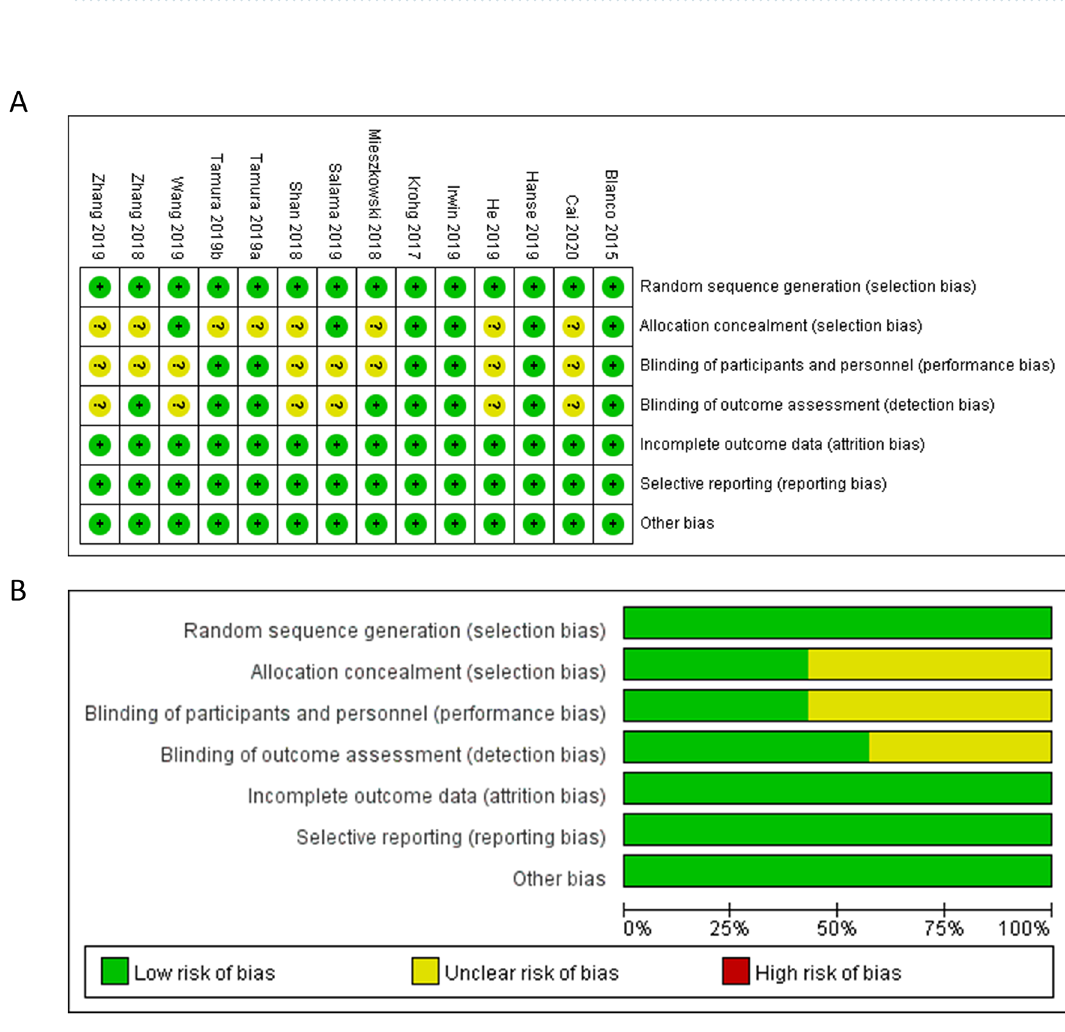
Figure 2. Quality assessment of included studies. The green circles indicate lack of bias; yellow circles indicate unclear bias. ( A ) Risk of bias for each included study. ( B ) The overall summary of bias of the included